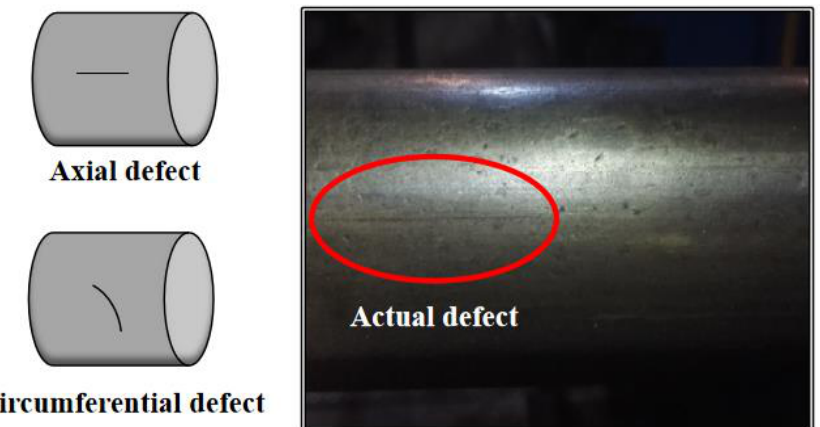
Figure 3. The defect location and sample diagram of the bar.